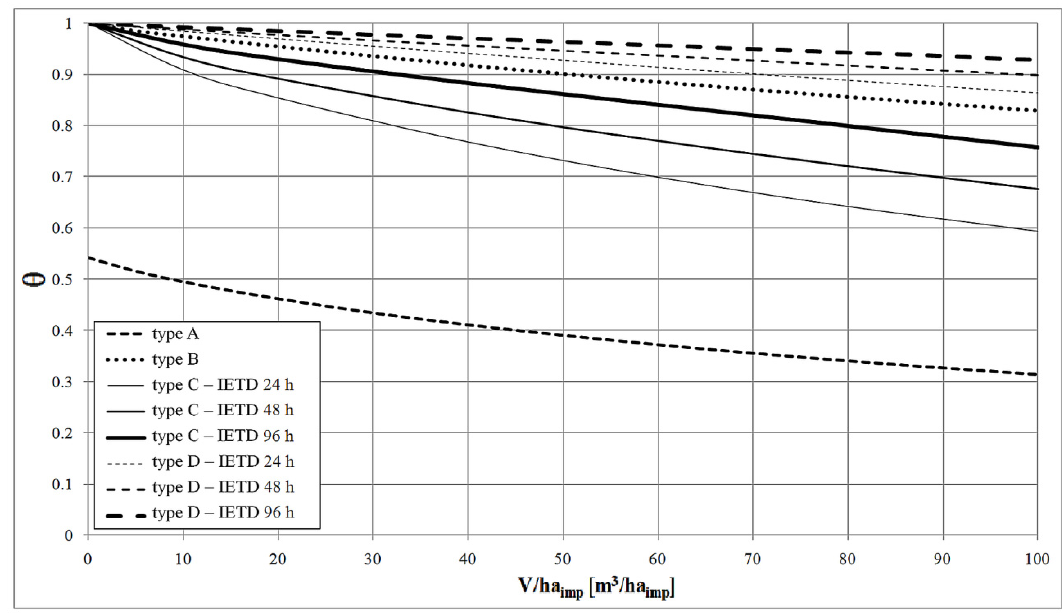
Figure 4. Cervinara station. Efficiency index θ compared to tank storage V/h from 0 to 100 m 3 /h aimp